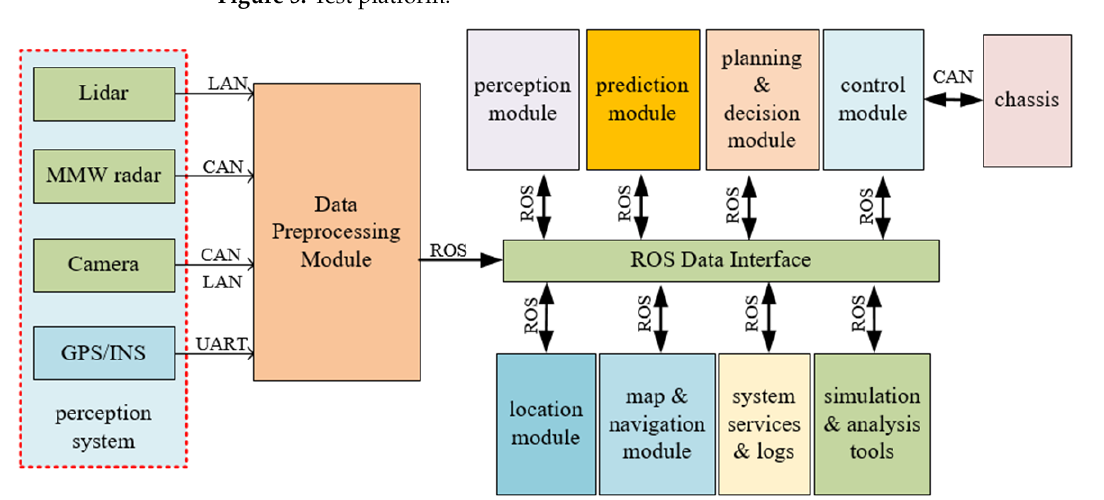
Figure 5. Test platform.